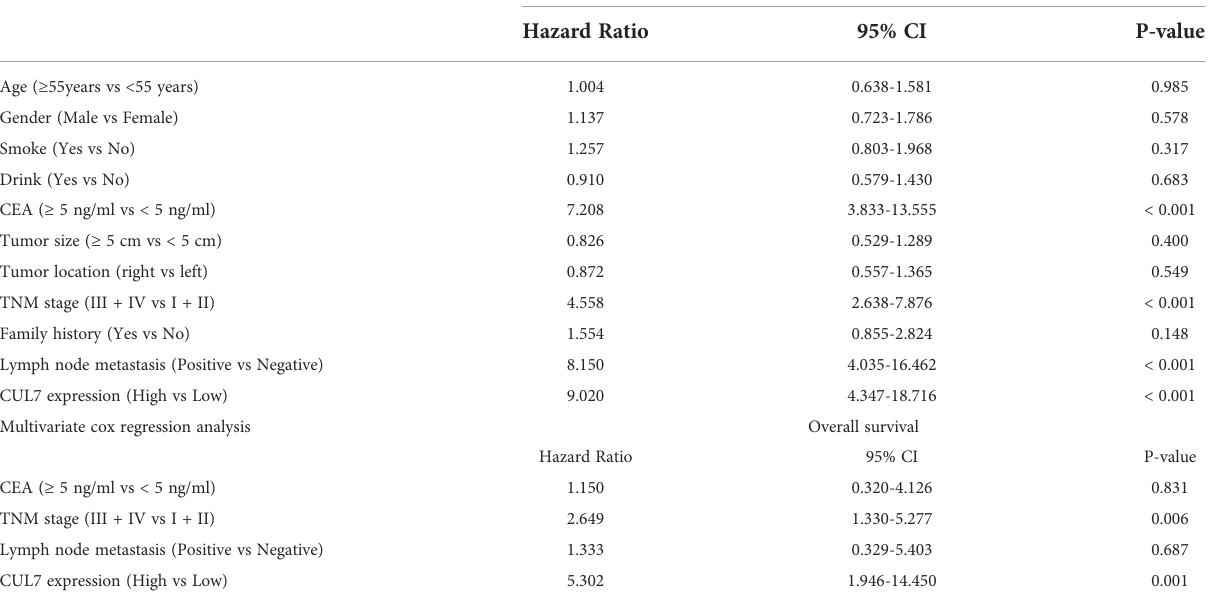
TABLE 1 Cox regression analysis of fi ve years overall survival in 100 COAD